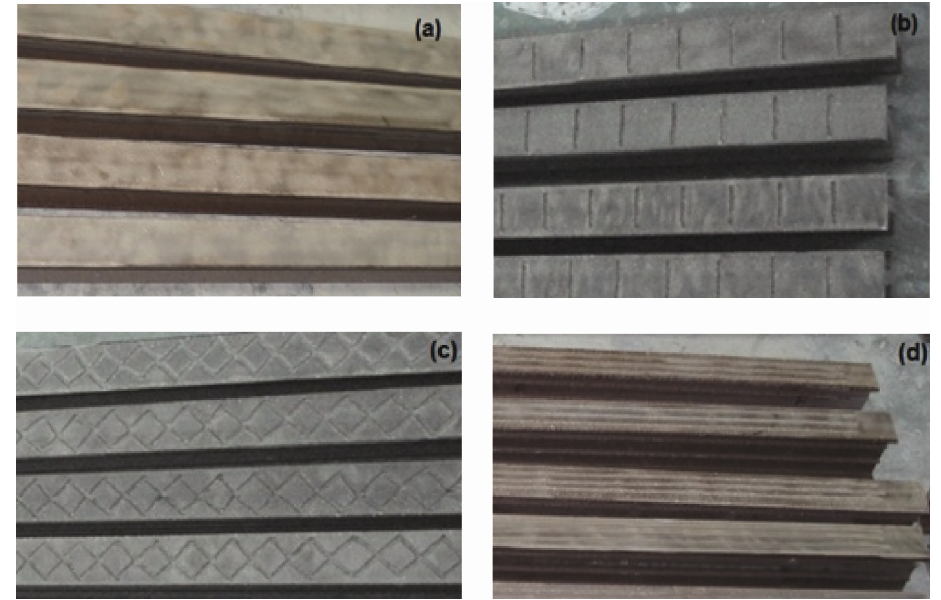
Fig. 5. Specimens in different shapes: (a) with surface preparation; (b) with transverse grooves; (c) with diagonal grooves; (d) with longitudinal grooves